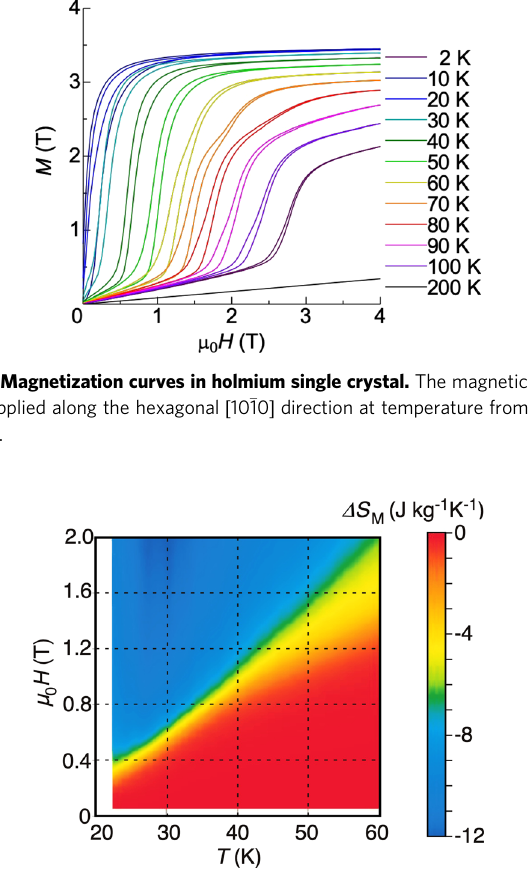
increases from zero. It can be seen that Δ S M (0, μ 0 H ) remains